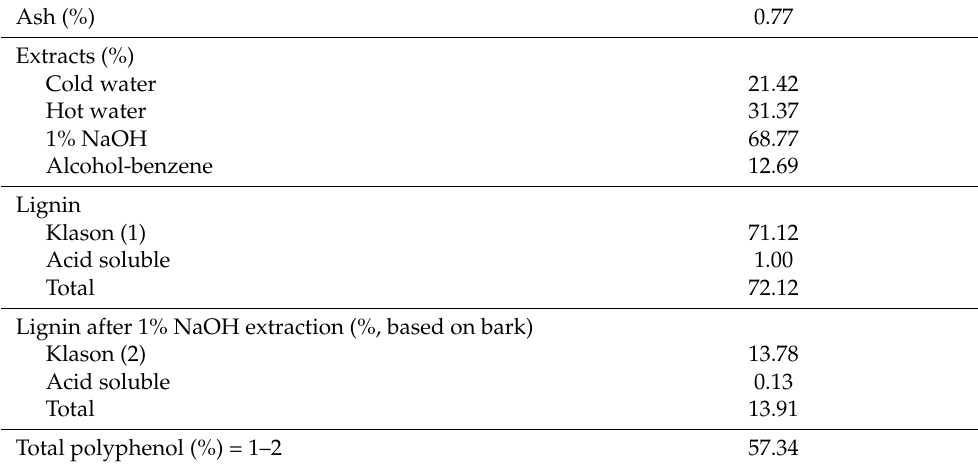
Table 1. Chemical composition of P. radiata